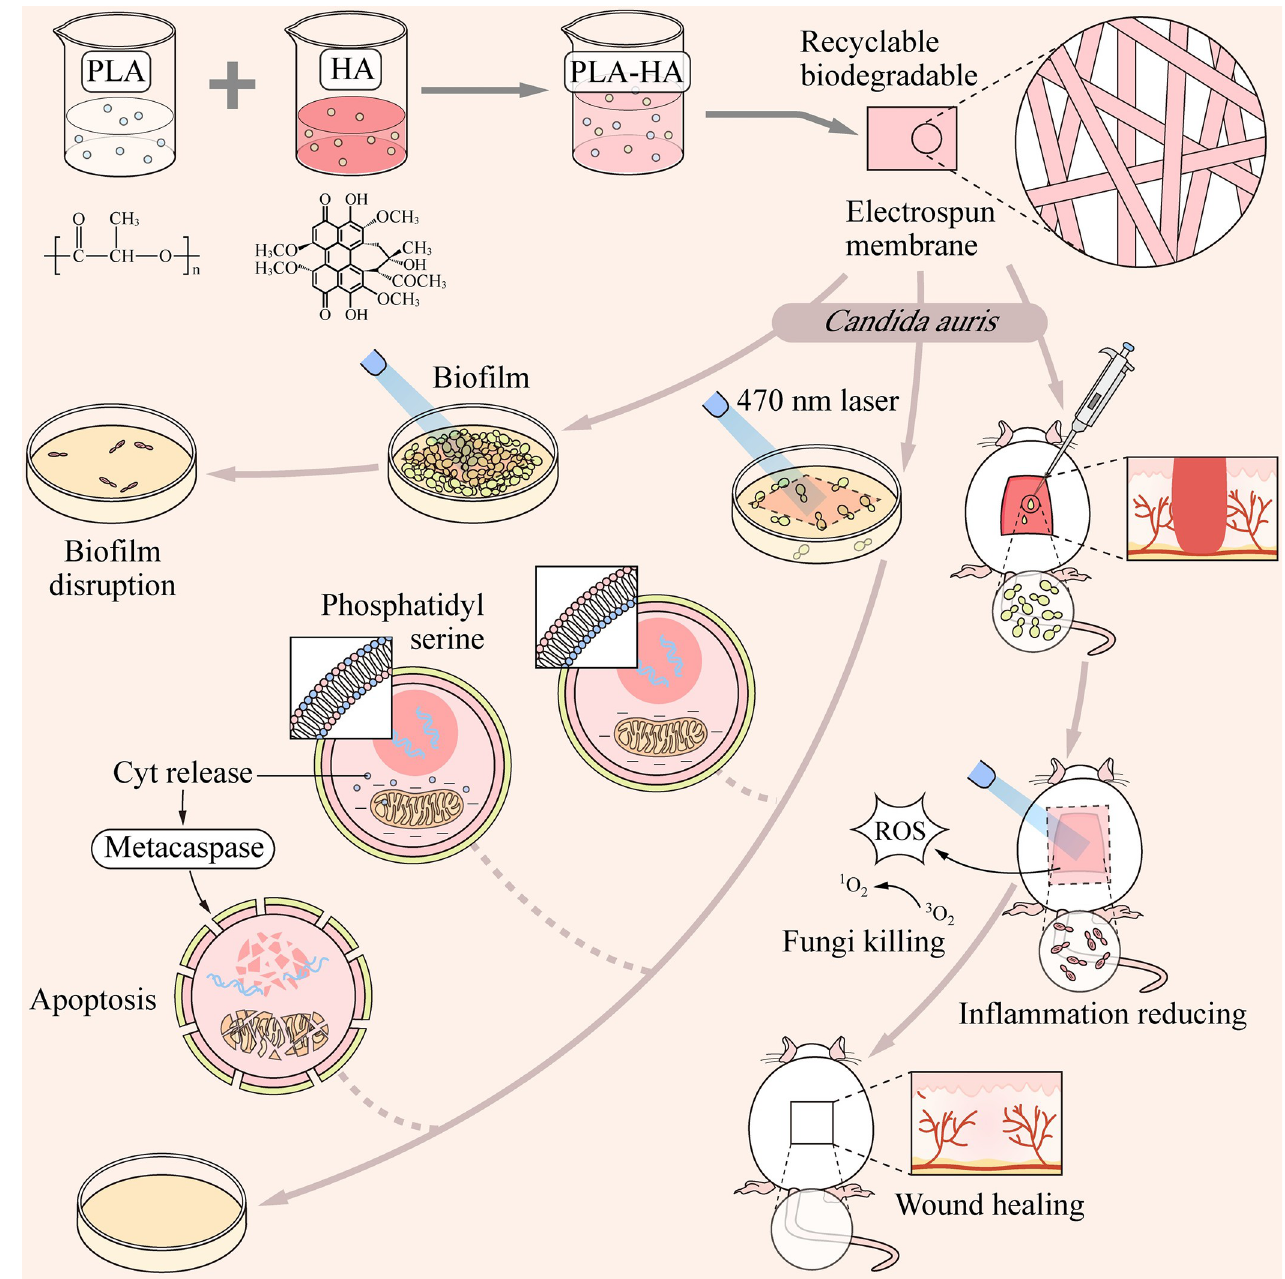
Fig 1. A schematic illustration of the synthetic route of the PLA-HA membrane and its antifungal applications in C . auris planktonic cells and biofilms, as well as the corresponding infected wound